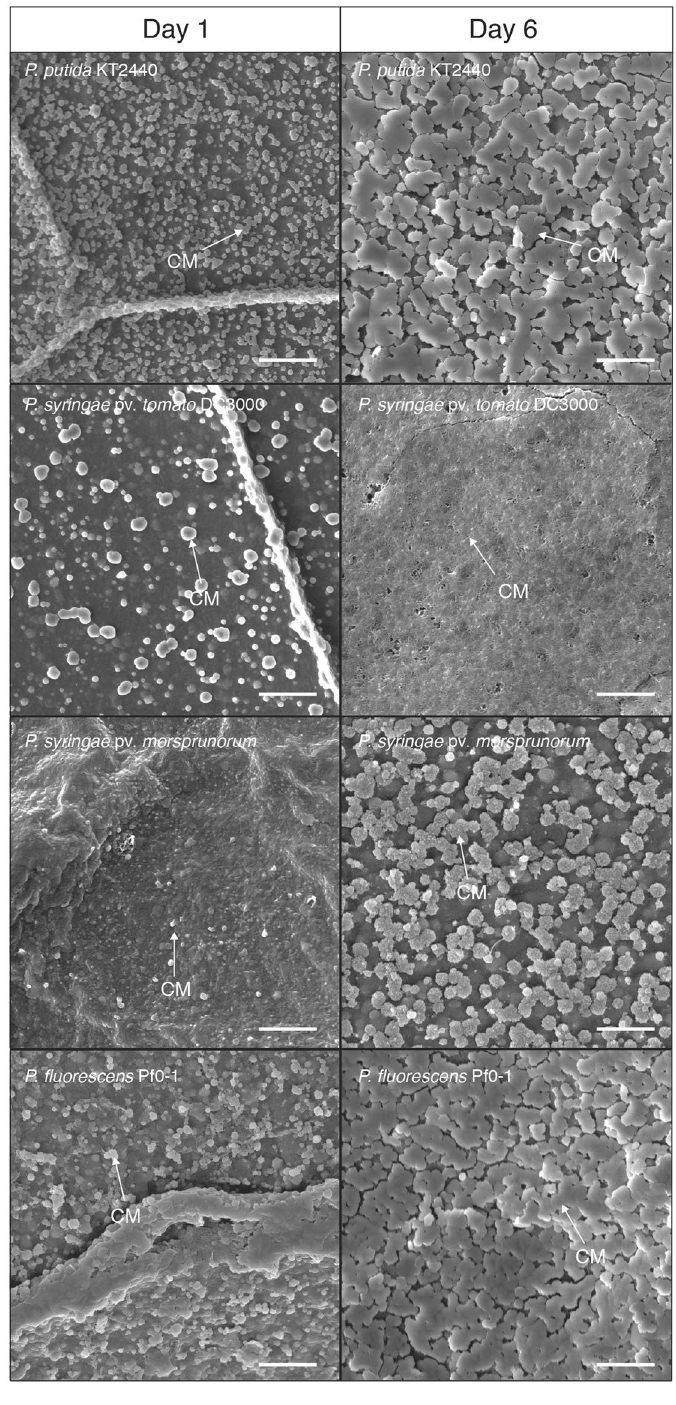
Figure 6. SEM images at 18,000x magnification of the agar adjacent to bacterial colonies for P. putida KT2440, P. syringae pv. morsprunorum 5795, P. syringae pv. tomato DC3000, and P. fluorescens Pf0-1 after 12 hours and six days of growth. 2 µ m scale bars are indicated in the lower right-hand corner of the images. Arrows labelled “CM” points to calcium phosphate that has formed on the agar. Imaging of the agar adjacent to colonies was performed three times using three separate biological replicates. This image is representative of what was observed with the other